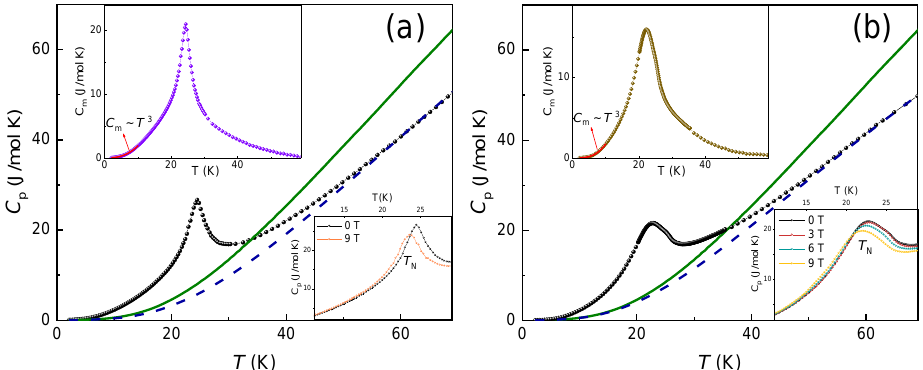
Figure 4. Temperature dependences of the specific heat in Li 2 Ni 2 TeO 6 ( a ) and K 2 Ni 2 TeO 6 ( b ). The data for Na 2 Zn 2 TeO 6 are shown by solid lines. The dashed lines represent the reference curves obtained through the scaling procedure [39]. Lower insets represent C p ( T ) curves measured at various magnetic fields. Upper insets represent temperature dependences of magnetic specific heat, C m .